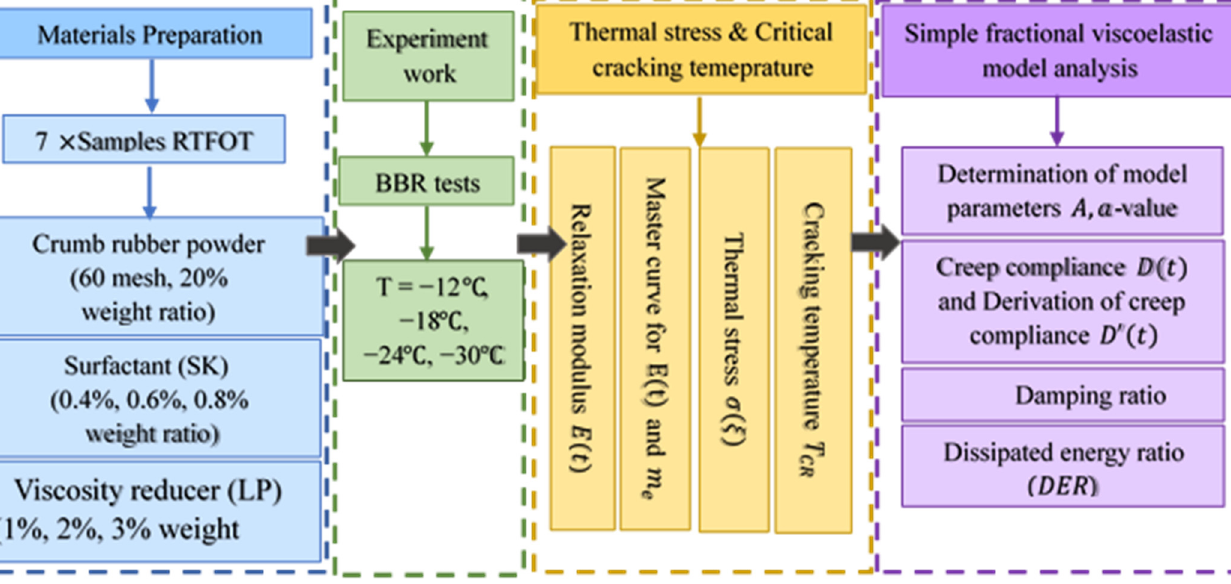
Figure 2. Schematic showing the research